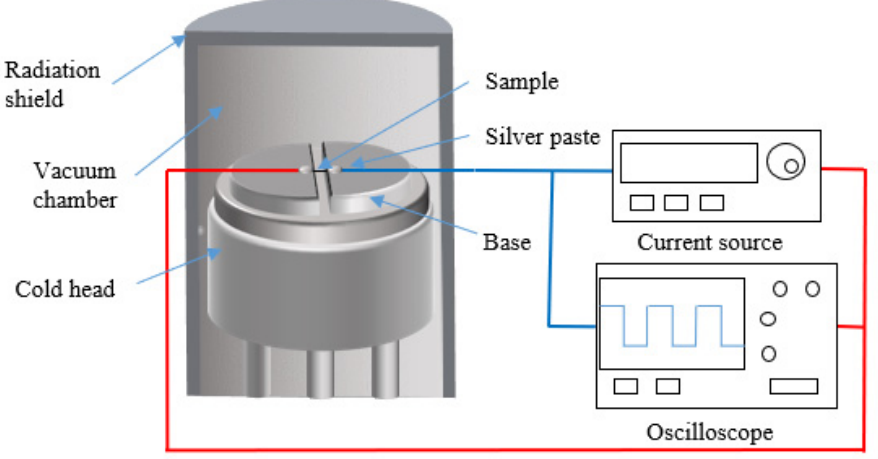
Figure 1. Schematic of the experimental principle and setup for the TET experiment. The length of sample is much larger than its diameter or width and thickness.